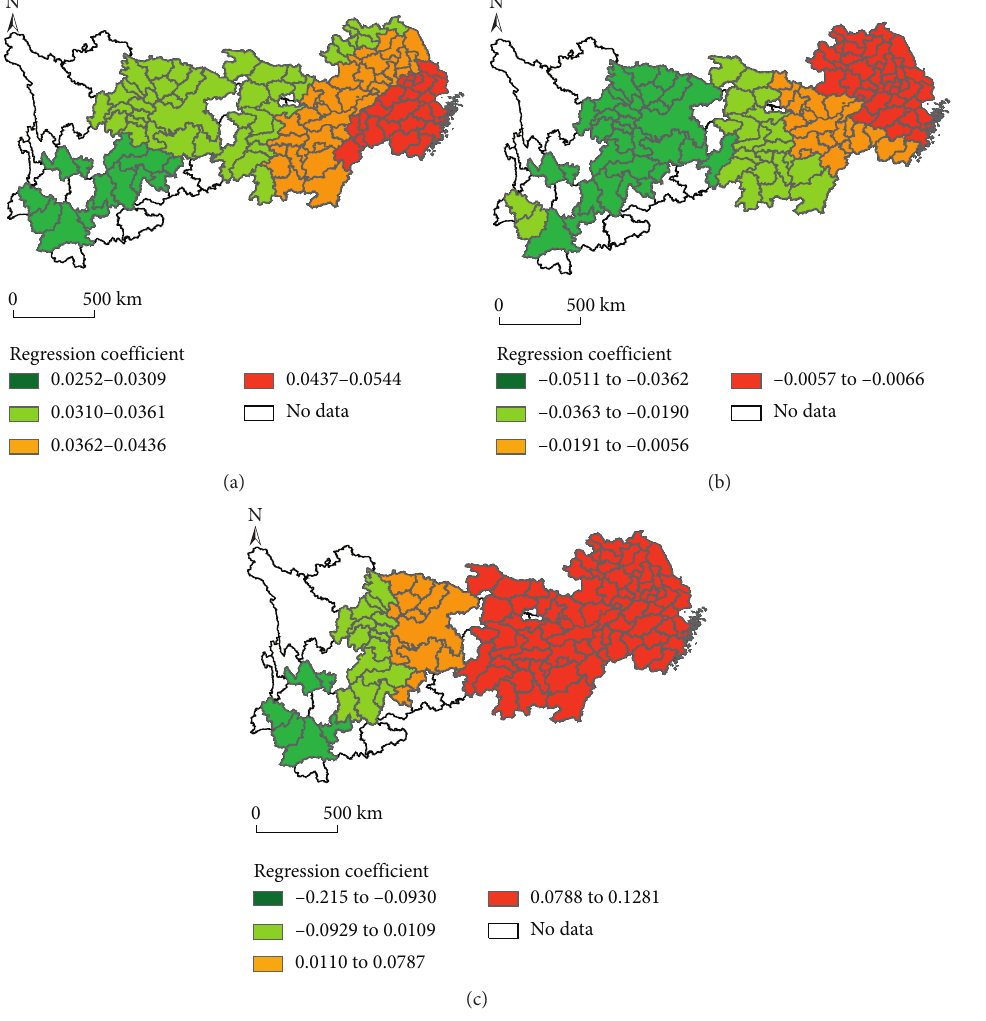
Figure 6: Spatial distribution of regression coefficient between innovation environment and innovation output. (a) Infrastructure en- vironment. (b) Economic environment. (c) Cultural and educational